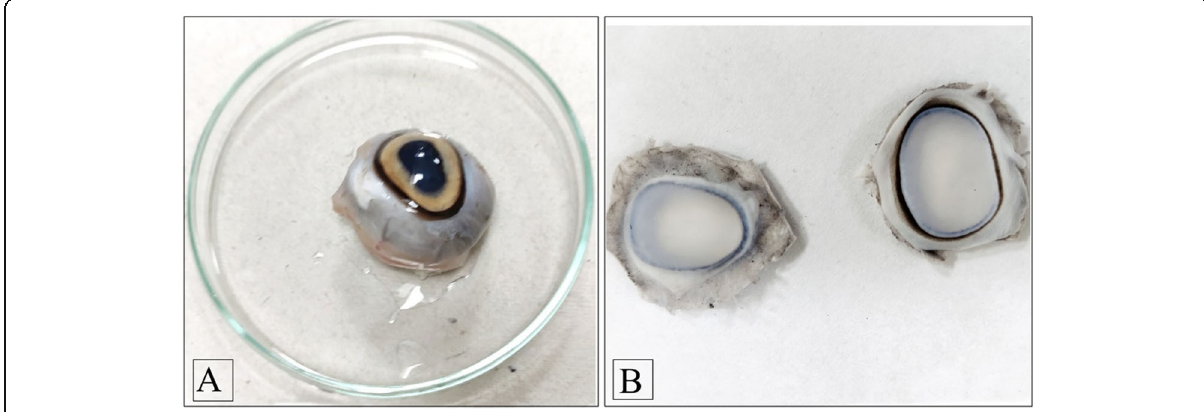
Fig. 11 Images showing the a freshly excised goat cornea and b dissected goat cornea with adhering